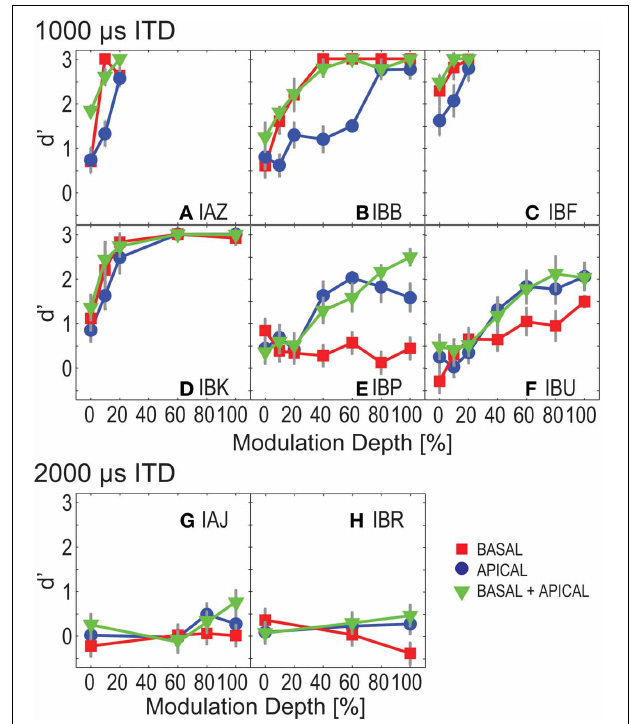
FIGURE 2 | ITD sensitivity as a function of modulation depth for Experiment 1. Each panel shows results for one listener. Basal-only, apical-only, and dual-site electrode configurations are shown by the different symbols. Panels show performance of “good” listeners (A–F) and poorer performers (G–H)